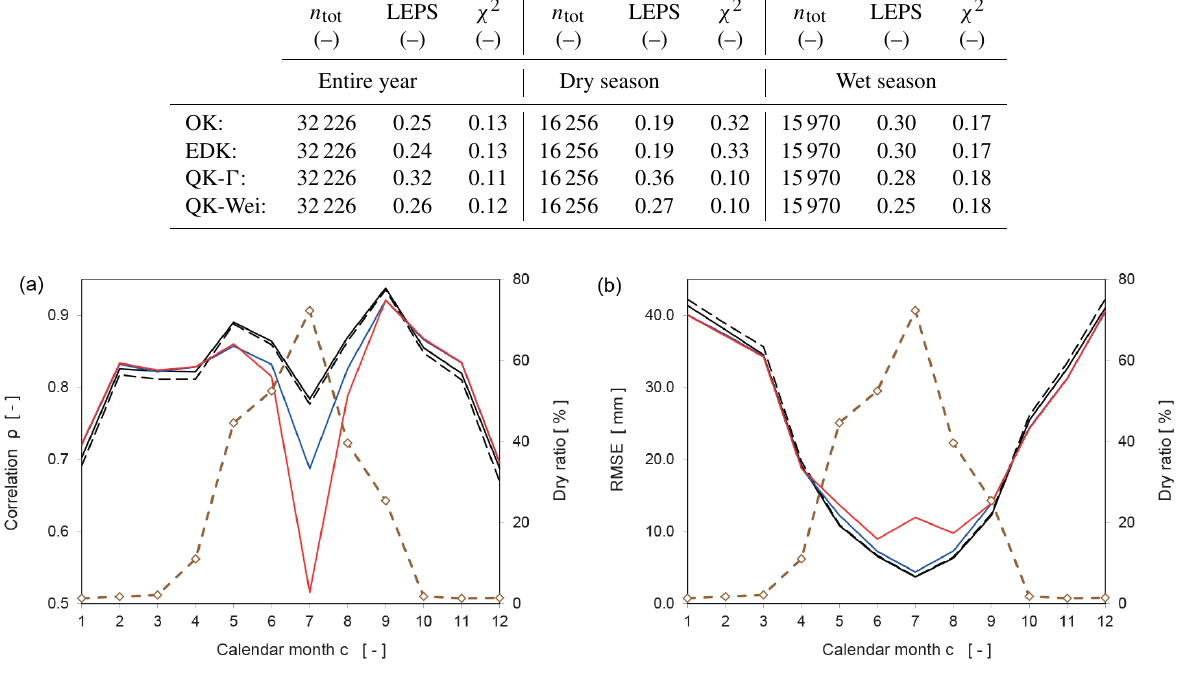
Figure 10. Evolution of two objective functions for the estimator over the 12 calendar months: Correlation coefficient ρ (a) and RMSE (b) . Note that the dry ratio (dashed brown line) is indicated as a percentage on the right axis.